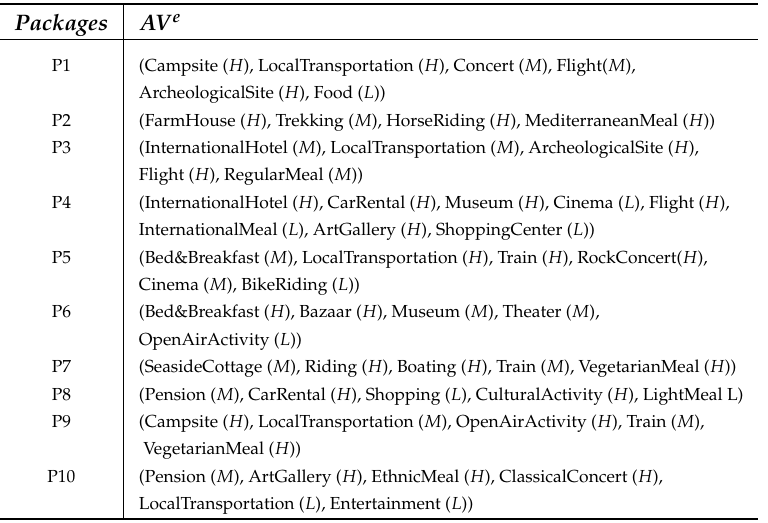
Table 2. Tourist